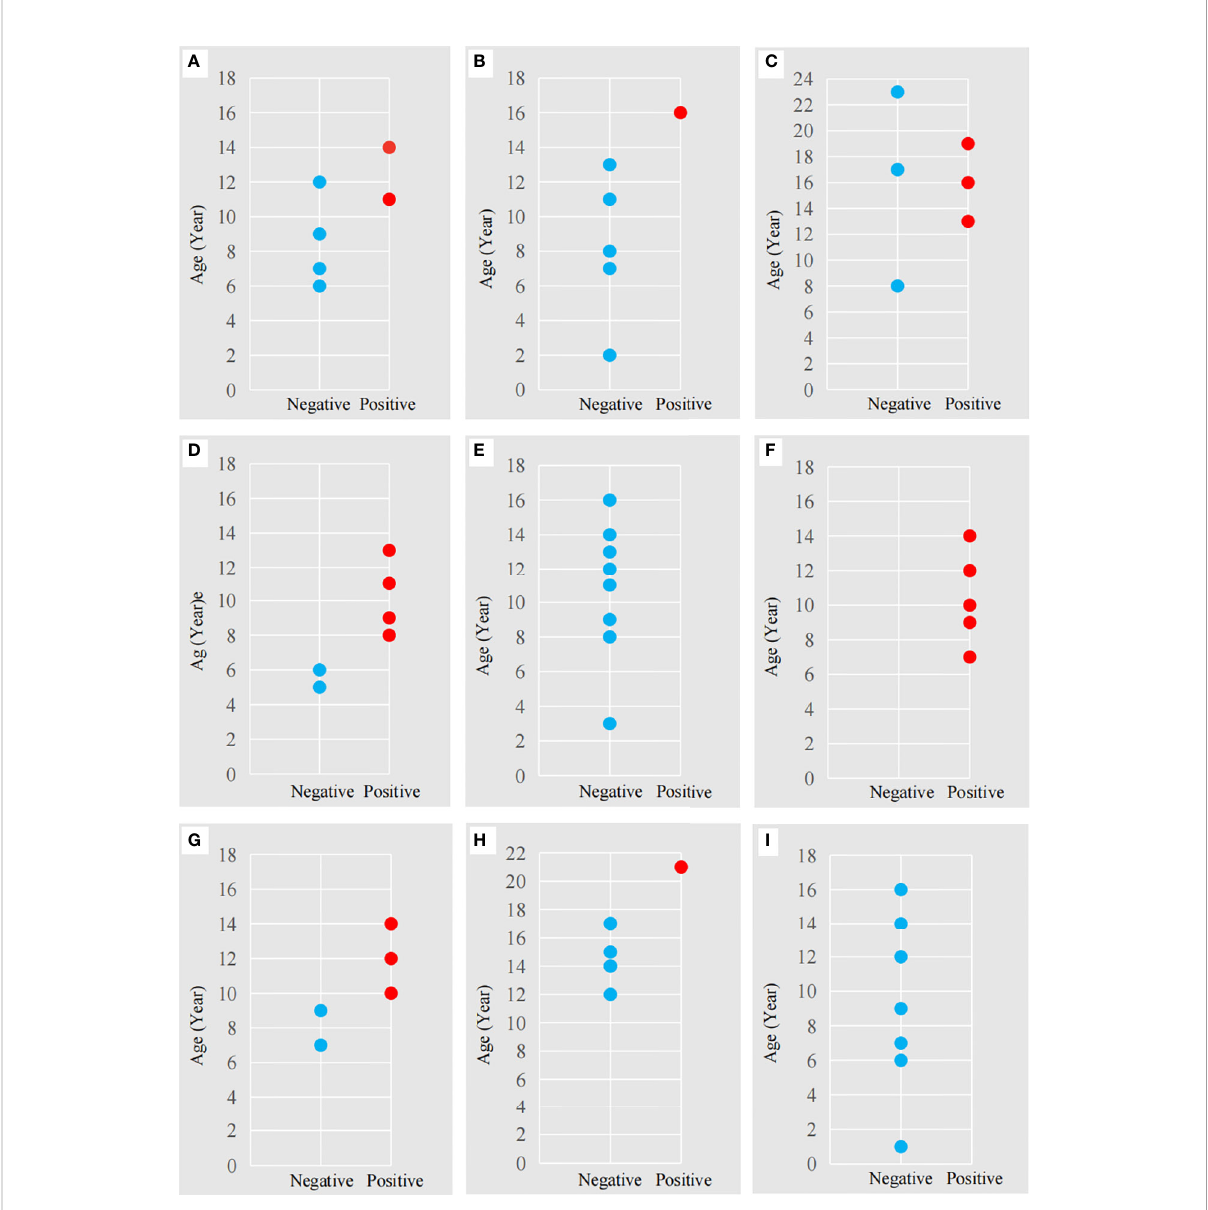
FIGURE 3 The antibodies to T. gondii in nine adult giant pandas at different ages. The letters (A-I) correspond to the nine adult giant pandas (Table 1) for which 55 serum samples were collected. Red dot: antibody-positive, Blue dot: antibody-negative. The abscissa represents a negative or positive result; The ordinate represents the age of the panda at the time of sample